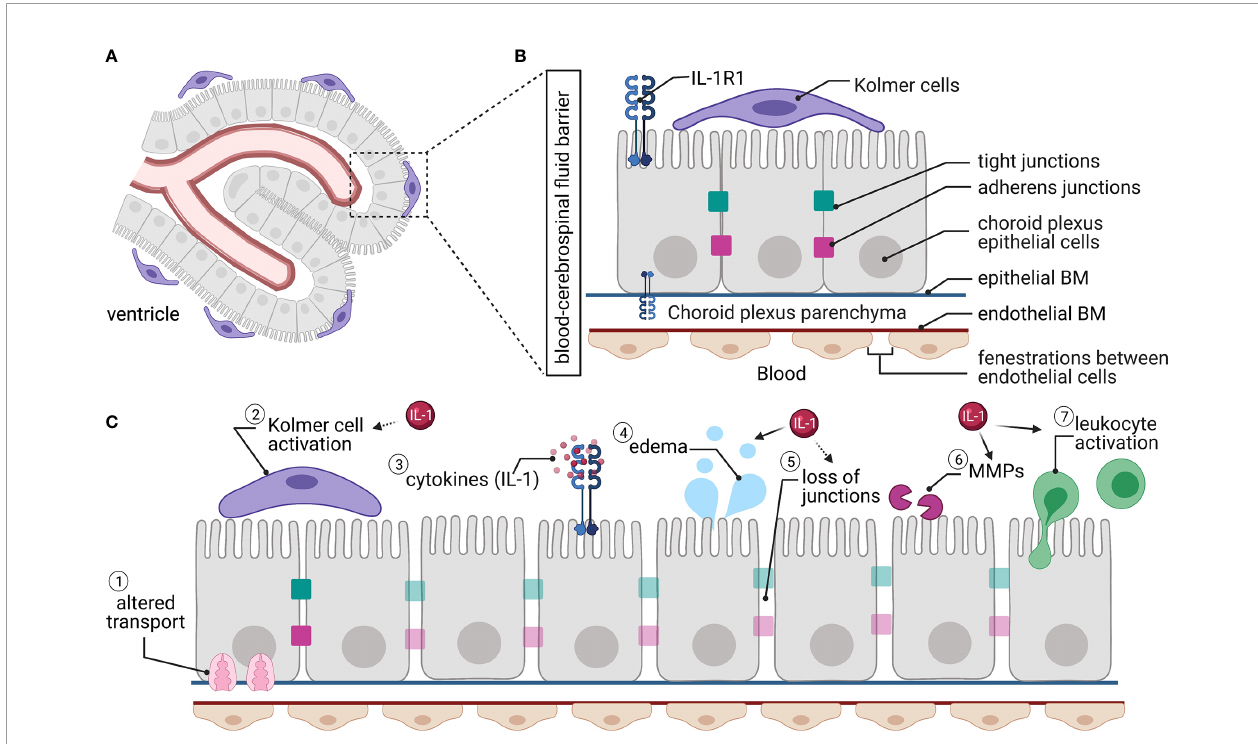
FIGURE 3 | The blood-CSF barrier. (A) The blood-CSF barrier surrounds the choroid plexus situated within the ventricles of the brain. (B) The blood-CSF barrier ’ s endothelial cells are fenestrated, while the choroid plexus epithelial cells have tight junctions and adherens junctions between adjacent cells, creating a barrier. Kolmer cells interact with the choroid plexus epithelial cells on the ventricle side. Interleukin-1 receptor 1 (IL-1R1) is located on epithelial cells. (C) Traumatic brain injury causes alterations to the blood-CSF barrier, including (1) altered transporter localization and expression; (2) Kolmer cells become activated and retract their processes; (3) local and systemic increased cytokines; (4) increased water permeability and edema; (5) loss of tight junctions; (6) matrix metalloprotease (MMP) activity; and (7) increased leukocyte traf fi cking and activation. Many of these changes have been linked directly (solid arrow) or indirectly (dashed arrow) to IL-1